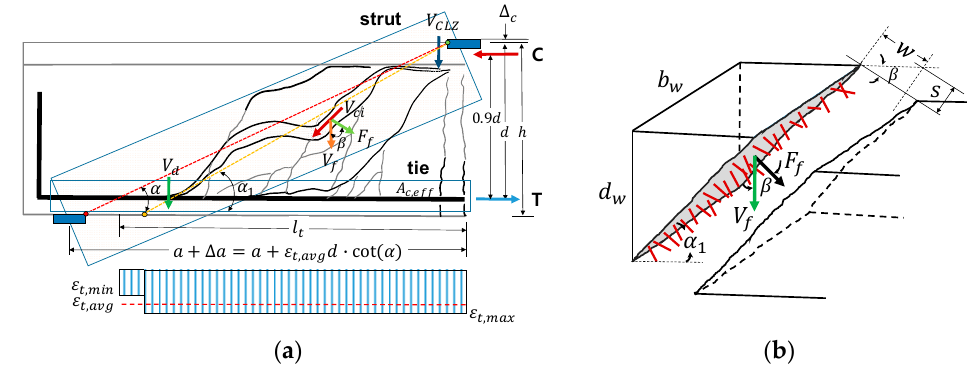
Figure 12. The principal assumptions of the kinematic model (with two degrees of freedom) and variation of the angle α 1 during transition from deep to slender beams. ( a ) Redrawn and modified from Mihaylov et al. (2013). ( b ) The relationships among the SF force, the SF-induced shear force, and the angle β .